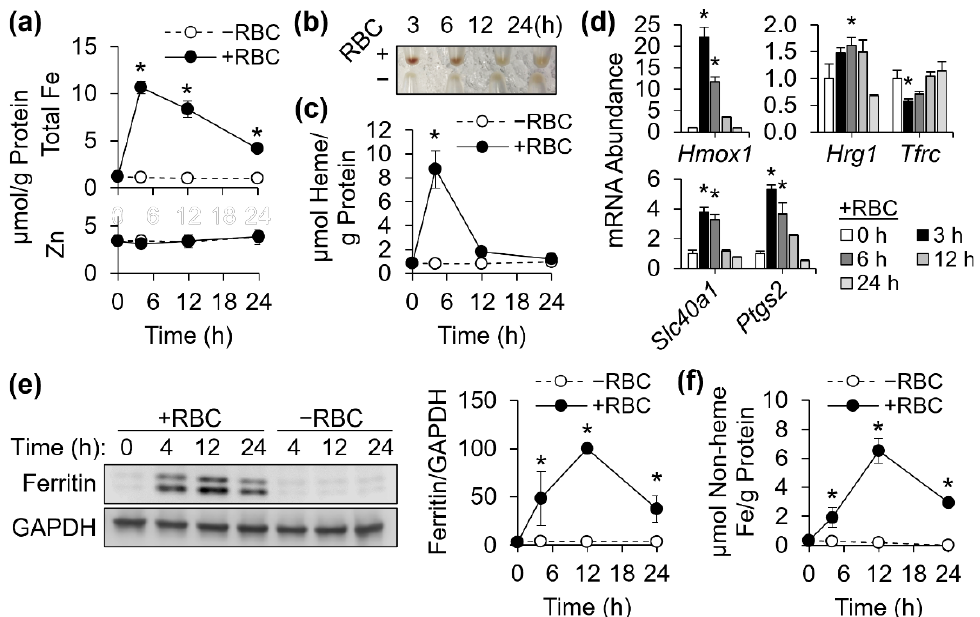
Figure 3. Cellular nonheme iron and ferritin protein contents transiently rise after erythrophagocytosis. J774 macrophages were treated with opsonized erythrocytes for 2 h to induce erythrophagocytosis, and then washed to remove residual non-ingested red cells. ( a ) Cellular contents of total iron and zinc after erythrophagocytosis, determined by ICP-MS and normalized to total protein contents ( n = 4 biological replicates). ( b ) Cell pellet images of J774 cells treated with or without opsonized red cells. ( c ) Cellular heme contents of J774 cells after erythrophagocytosis, normalized to total protein levels ( n = 4 biological replicates). ( d ) Regulation of gene transcripts related to iron transport ( Hrg1 , Tfrc , Slc40a1 ) and oxidative stress ( Hmox1 , Ptgs2 ) by erythrophagocytosis, normalized to Tbp ( n = 3 biological replicates). ( e ) Immunoblotting of ferritin, and temporal expression pattern of ferritin abundance normalized to GAPDH after erythrophagocytosis ( n = 4 independent experiments). ( f ) Cellular nonheme iron contents, calculated by subtracting normalized heme iron from total iron contents, after erythrophagocytosis ( n = 4 biological replicates). All data presented as mean ± SD. *, p <